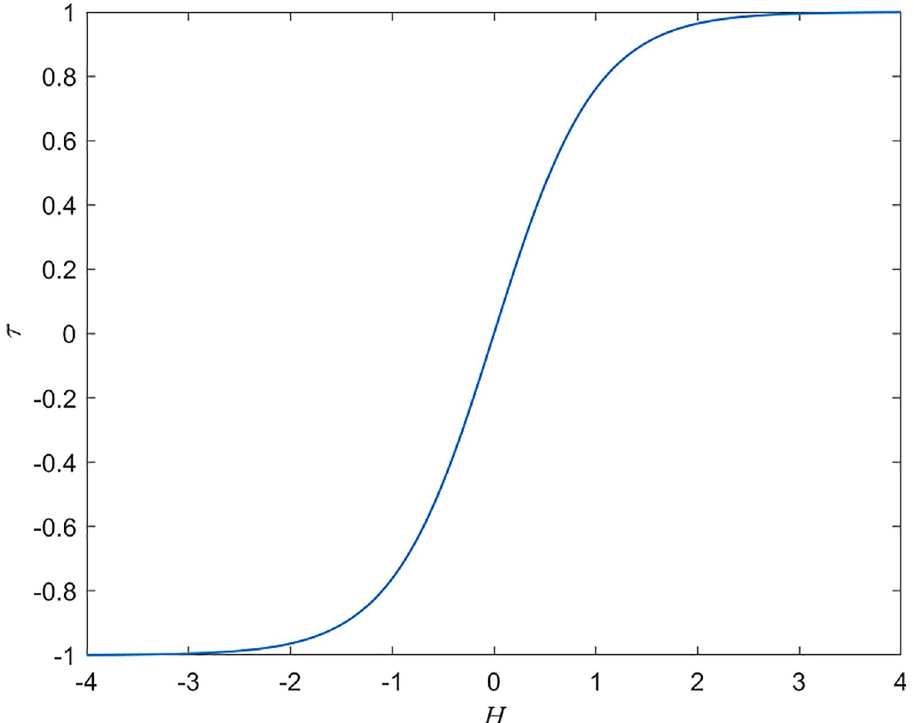
Fig 1. The evolution tendency of τ with H changing from negative to